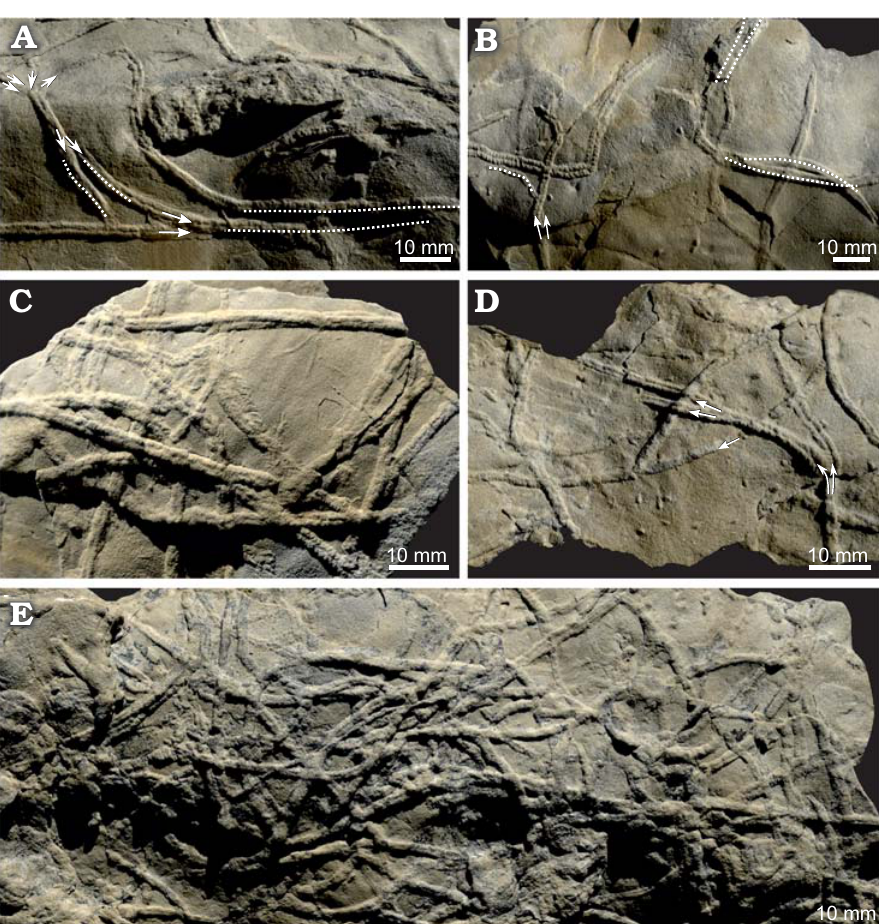
Fig. 7. “Burrowing highways” of Gyrochorte comosa Heer, 1865 in the Mulichinco Formation, Lower Cretaceous, Puerto Curaco, Neuquén Province, Argentina (field photographs). Crowded parallel and overlapping G. comosa concentrated at ripple crest ( A – E ). Note acute angle between sequorichnial Gyrochorte ichsp. (arrows, traces converging to and diverging from a parallel course; doted lines, parallel/overlapping traces). All specimens left in the